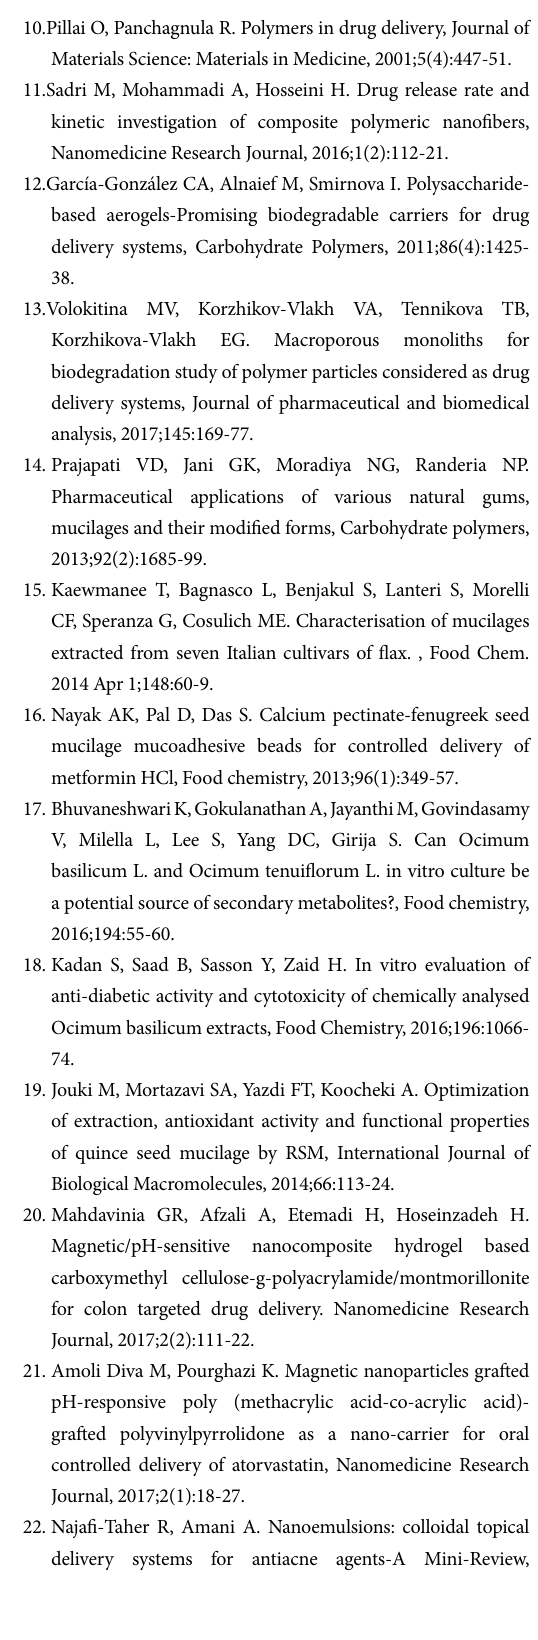
187 Nanomed Res J 2(3): 179-188, Summer